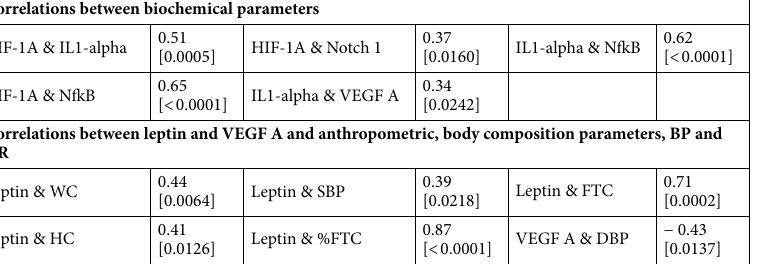
Table 8. Significant correlations between registered parameters in group K. Data presented as the Spearman correlation coefficient R value; p value is presented below R value in square bracket []. %FTC: percentage fat tissue content; DBP: resting diastolic blood pressure; FTC: mass fat tissue content; HC: hip circumference; HIF-1A: hypoxia-inducible factor 1 alpha; IL1-alpha: interleukin 1 alpha; NfkB: nuclear factor kappa-light- chain-enhancer of activated B cells; Notch 1: Notch protein 1; SBP: resting systolic blood pressure; VEGF A: vascular endothelial growth factor A; WC: waist circumference.